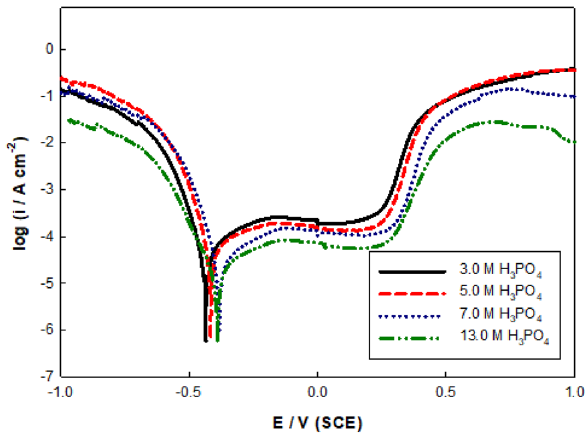
Figure 2. Potentiodynamic polarization curves in different concentrations of H 3 PO 4 at 298 K.